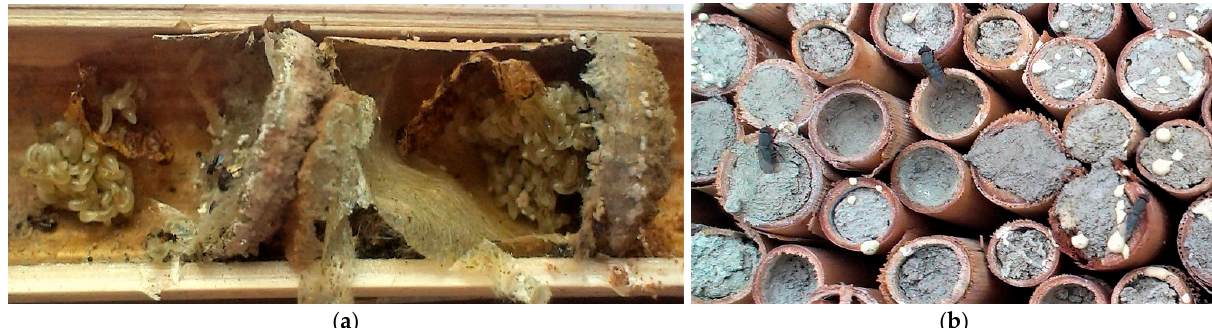
Figure 6. Occurrence and prevalence of brood parasites and clinically visible chalkbrood in various types of bees’ nesting material and rearing conditions at four locations (L1—different nesting material: extracted cocoons—( a ), plastic lamella—( b ), reed tubes—( c ), L2, L3, L4).